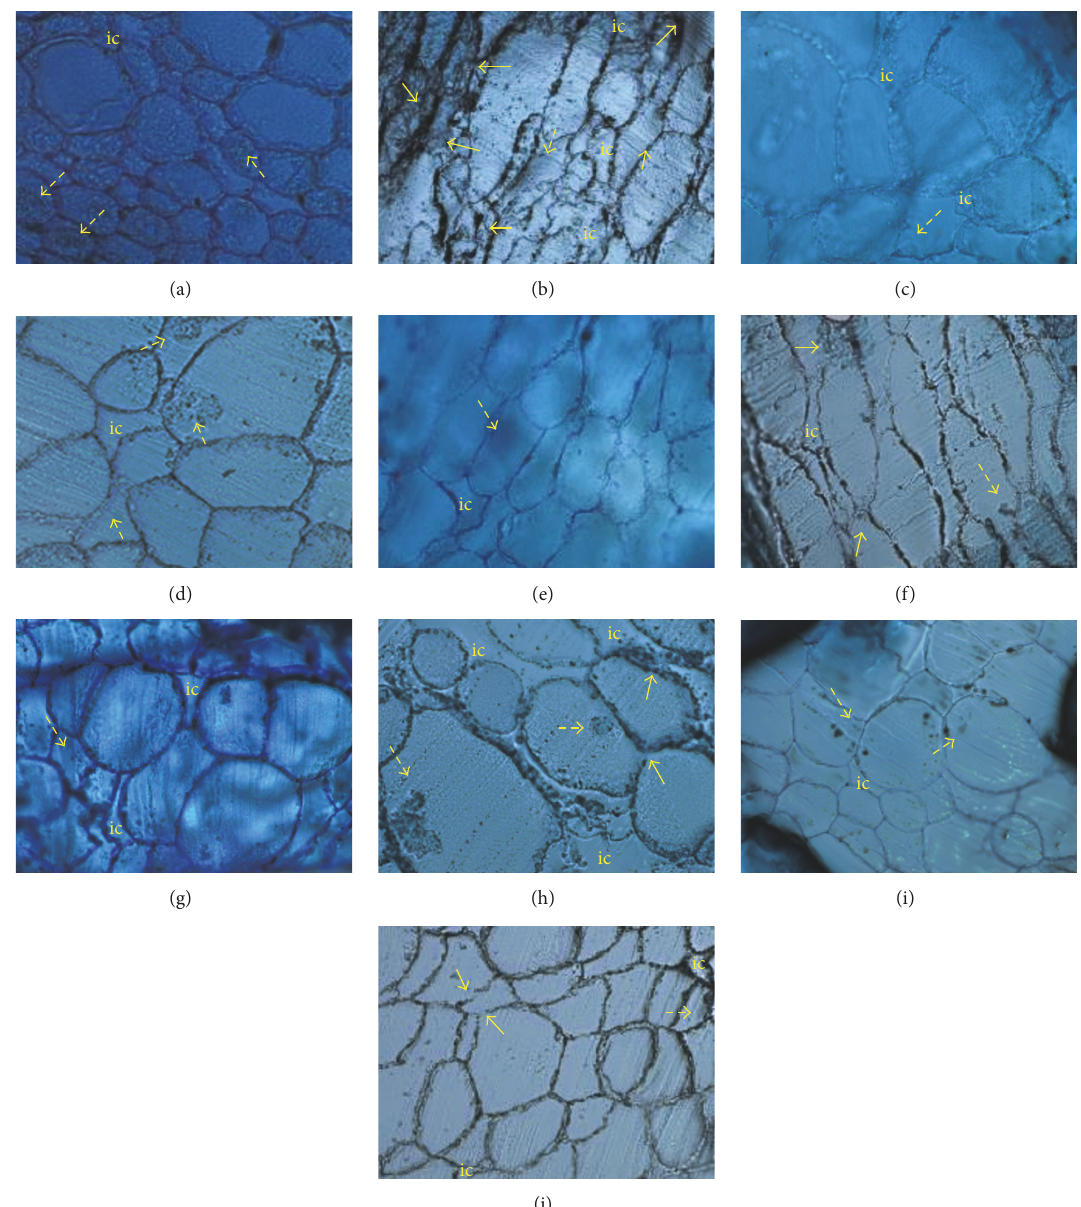
Figure 2: Micrograph of longan fruits tissue stored at 28 ± 1 ∘ C. (a)-(b) Untreated longan fruits; (c)-(d) UV irradiation followed by chitosan- based coating (UV + CHI); (e)-(f) chitosan-based coating followed by UV irradiation (CHI + UV); (g)-(h) UV irradiation followed by carrageenan-based coating (UV + CAR); (i)-(j) carrageenan-based coating followed by UV irradiation (CAR + UV). (a), (c), (e), (g), and (i) Day 2; (b), (d), (f), (h), and (j) day 7. → : cell wall damage; [ : cellular plasmolysis; ic: intercellular space.